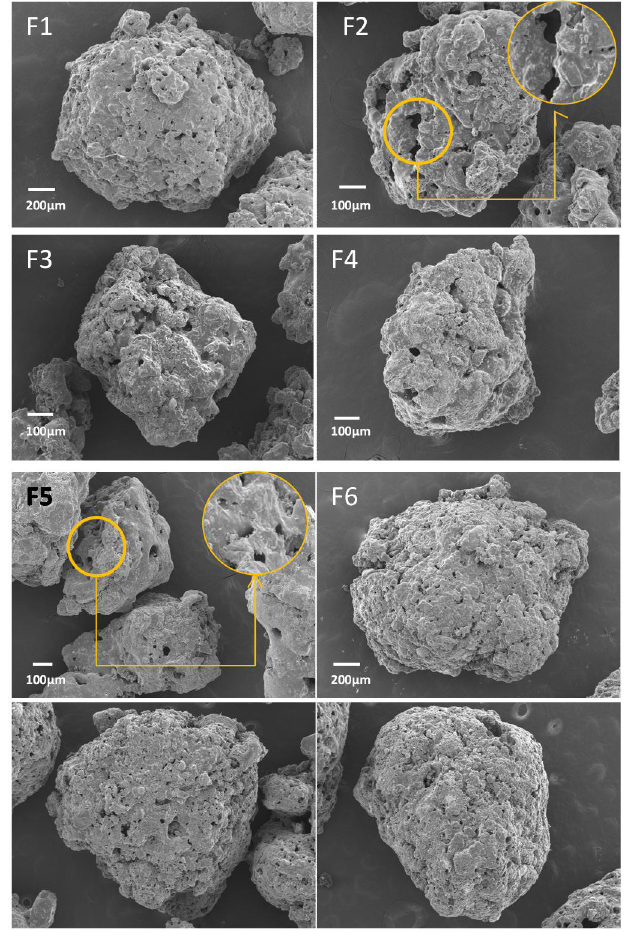
FIGURE 3 - Scanning electron micrographs of Maytenus ilicifolia formulations of effervescent granules (F1, F2, F3, F4, F5, F6, F7 and F8) obtained from the factorial design. The pores of F2 and F5 are shown in detail.